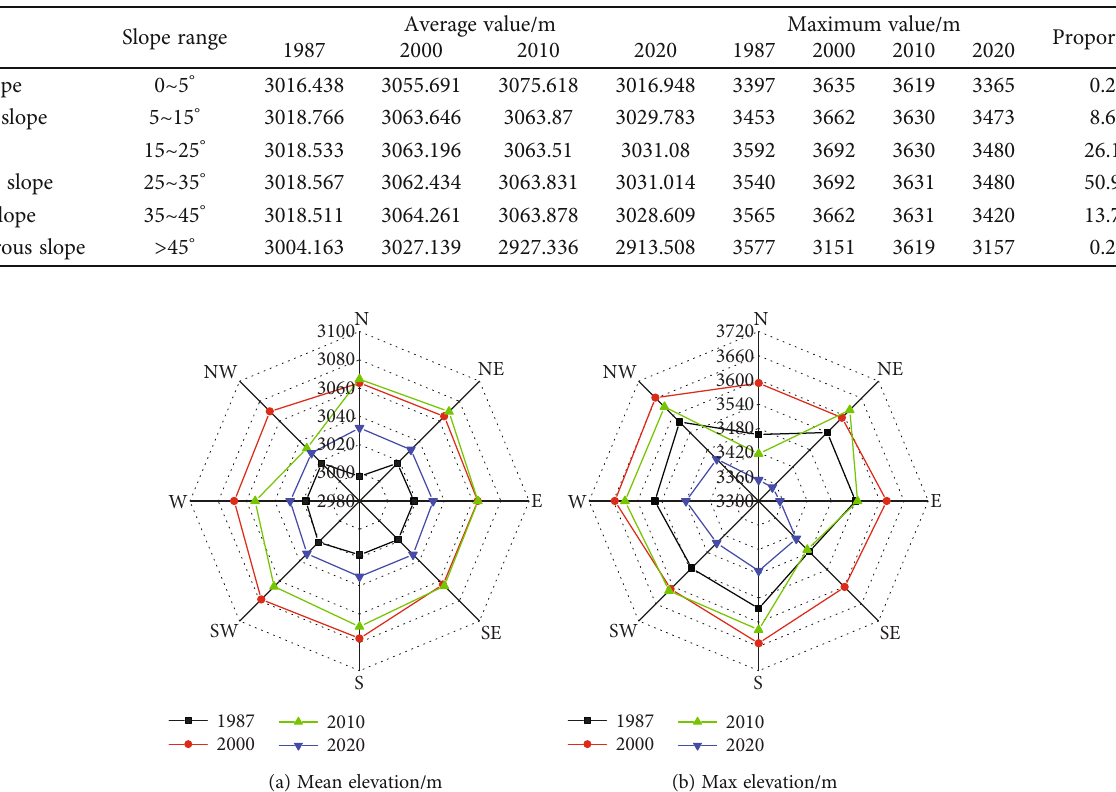
Figure 3: Treeline elevation distribution. Table 3: Treeline elevation distribution with di ff erent slope types.